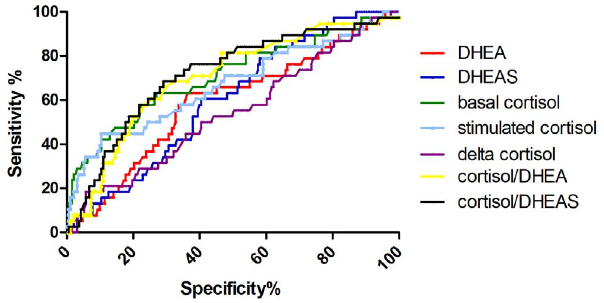
Figure 2. ROC of adrenal values. Dehydroepiandrosterone (DHEA): Area 0.59, Std. Error 0.05, 95% CI 0.49–0.69, p=0.07 Dehydroepian- drosterone-sulfate (DHEAS): Area 0.60, Std. Error 0.04, 95% CI 0.51–0.69, p=0.048. Basal cortisol: Area 0.71, Std. Error 0.05, 95% CI 0.61–0.80, p , 0.0001. Stimulated cortisol: Area 0.67, Std. Error 0.05, 95% CI 0.57– 0.77, p=0.001. Cortisol/DHEA: Area 0.70, Std. Error 0.05, 95% CI 0.61– 0.79, p , 0.0001. Cortisol/DHEAS: Area 0.71, Std. Error 0.05, 95% CI 0.63– 0.81, p ,